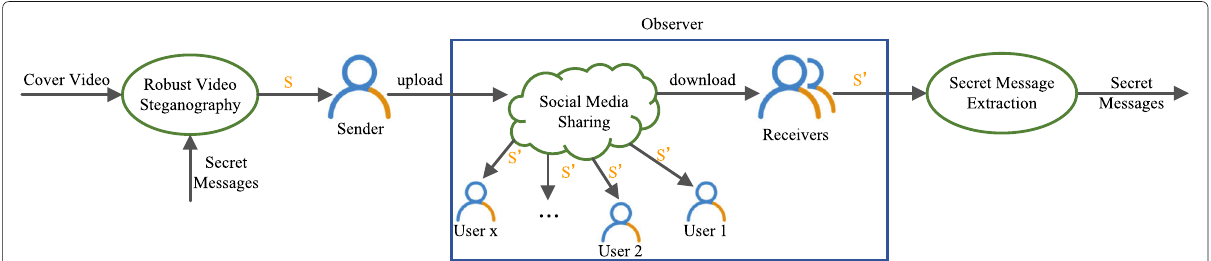
Fig. 1 The model of hidden communication based on social media sharing. The sender uploads the stego video to social media platforms or sites. The receivers download the transcoded video for secret message extraction. Hidden communication is carried out based on social media sharing. S represents the stego video carried with secret messages. S’ is the transcoded version of S messages to many receivers. But the observer cannot even distinguish the receivers from ordinary users.